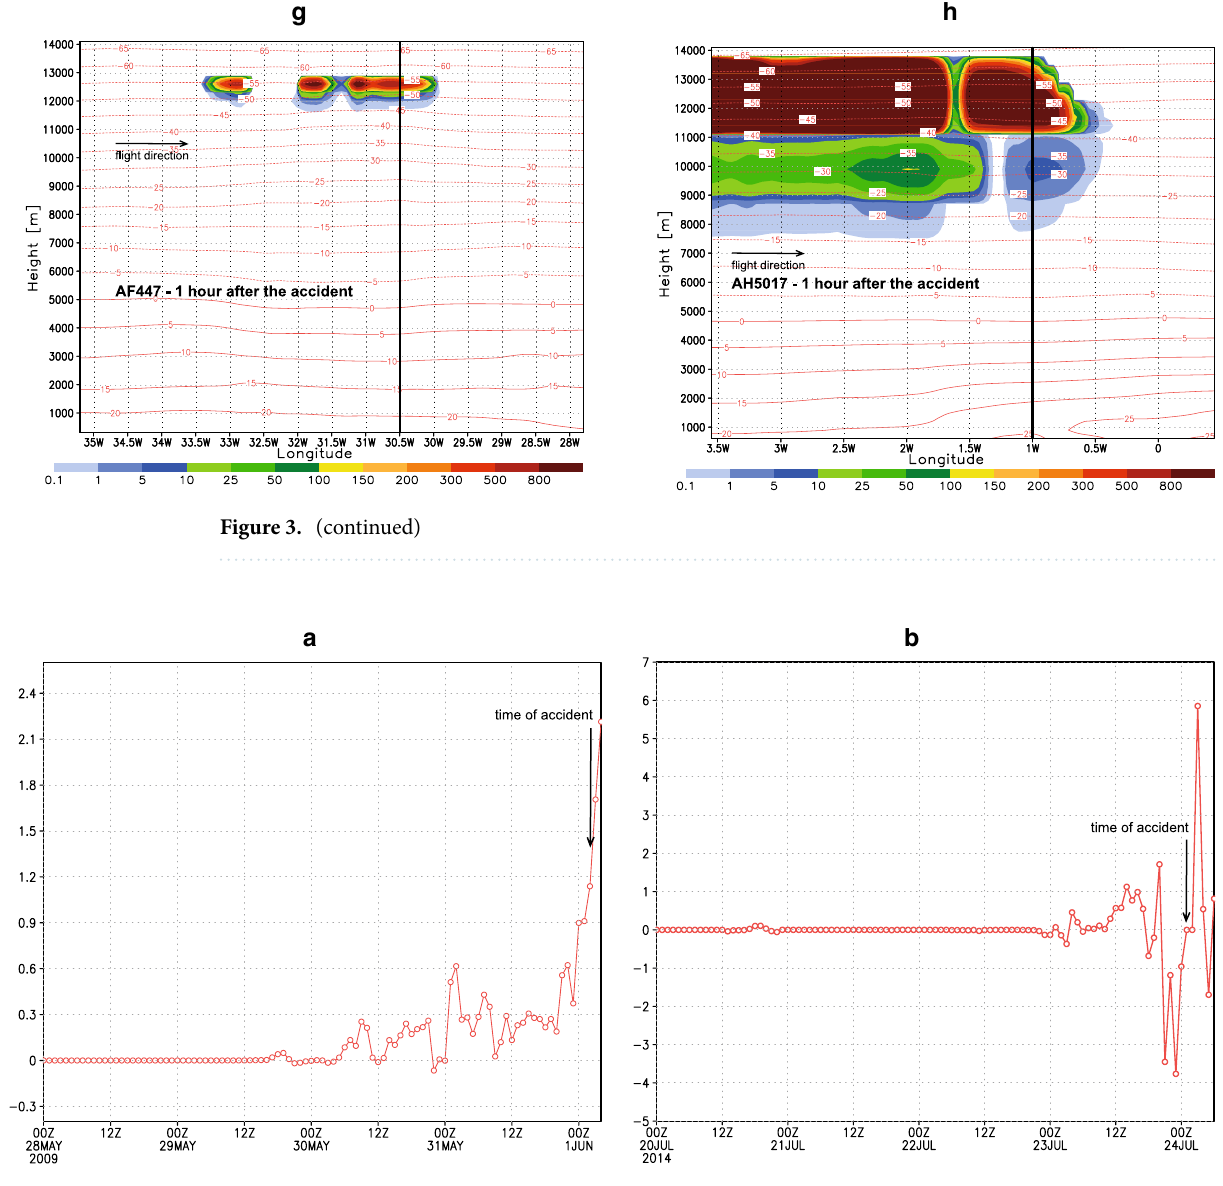
Figure 4. ( A , B ) Time evolution of Dust Icing Index DII at the flight levels of AF477 (left) and AH5017